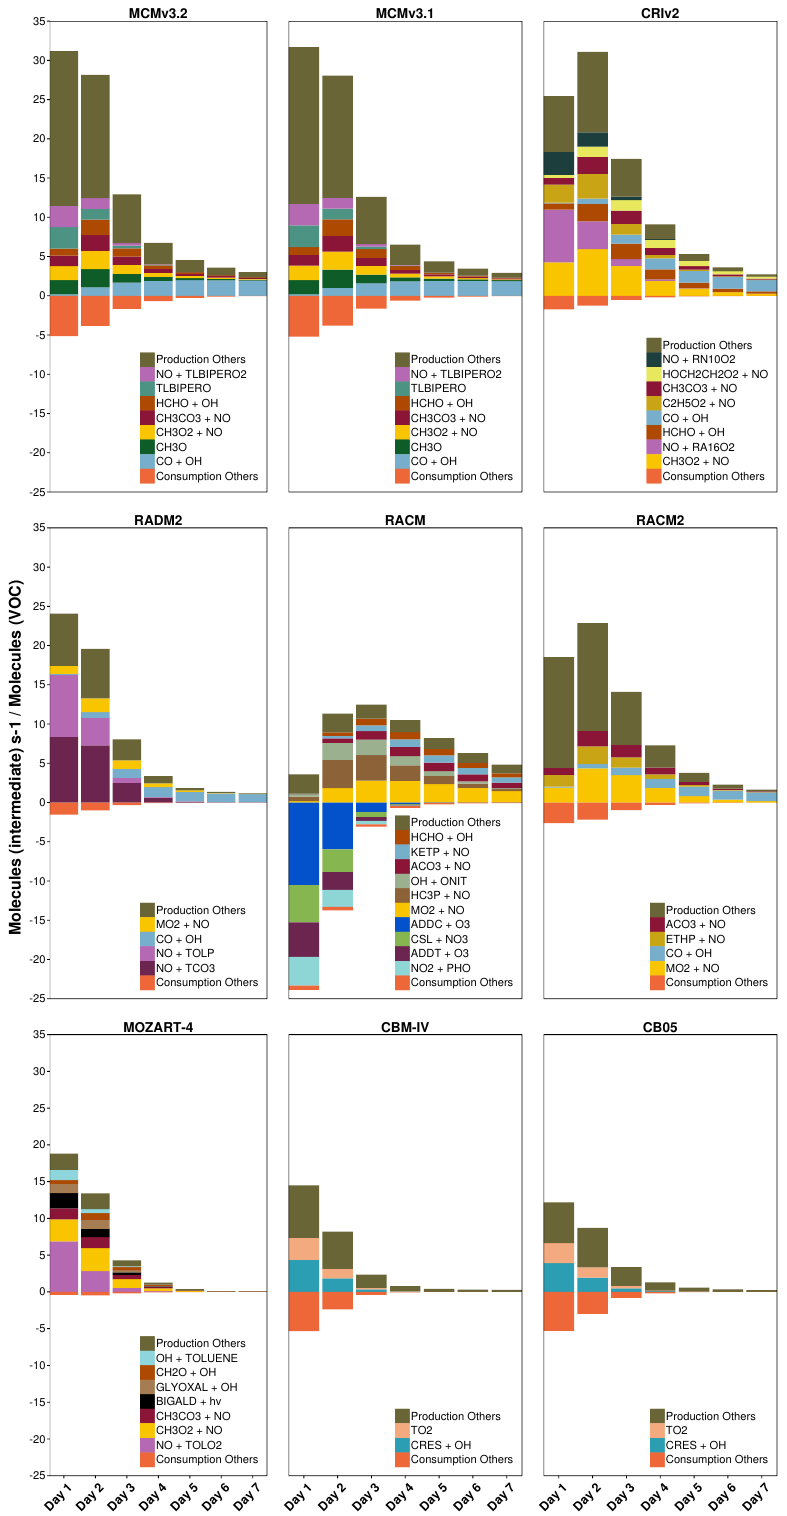
Figure 5. Day-time O x production and loss budgets allocated to the responsible reactions during toluene degradation in all mechanisms. These reactions are presented using the species defined in each mechanism in Table